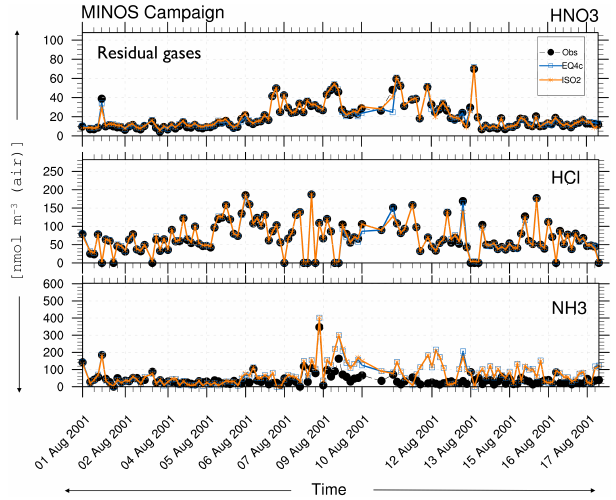
Figure 9. Residual gases [ µmolm − 3 ( air ) ] corresponding to Fig.